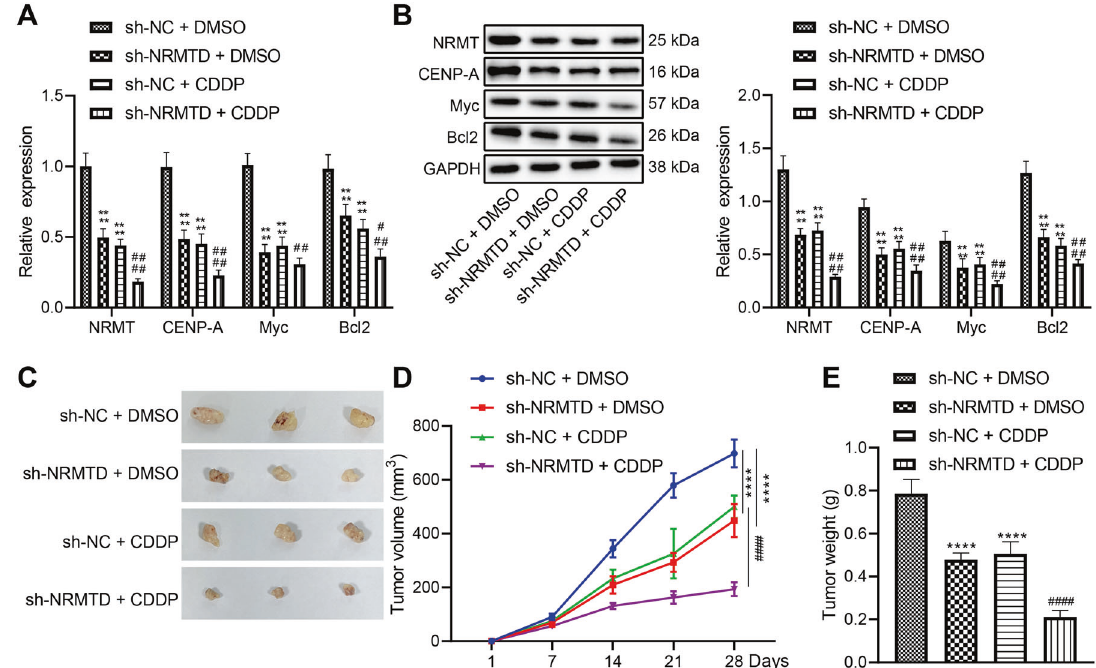
Fig. 6 NRMT acted as an oncogene in retinoblastoma by inhibiting chemosensitivity in vivo. A The expression of CENPA, Myc, and Bcl2 determined by RT-qPCR. B The expression of CENPA, Myc, and Bcl2 determined by western blot analysis. C Representative images of xenografted tumors. D The statistical graph of tumor volume. E The statistical graph of tumor weight. * p < 0.05 vs. mice infected with sh-NC + PBS, # p < 0.05 vs. that of mice infected with sh-NC + CDDP. * /# p < 0.05; ** /## p < 0.01; *** /### p < 0.001; **** /#### p < 0.0001. The experiment was independently repeated three